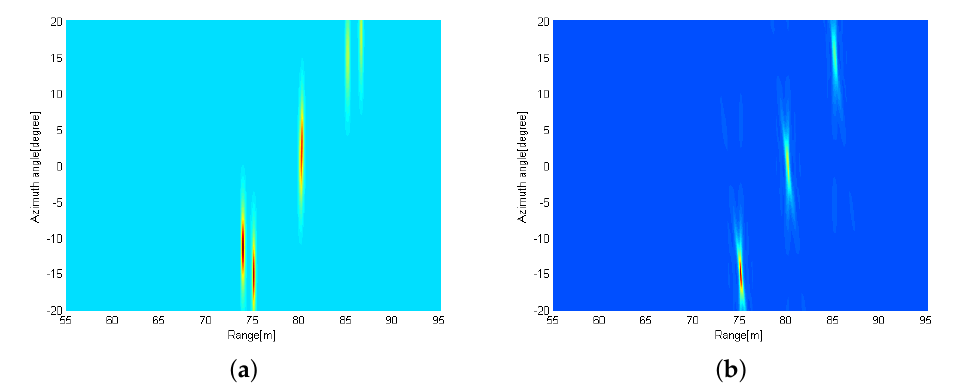
Figure 4. Radar images obtained by using ( a ) the conventional 2D MUSIC with SNR = 10 dB and ( b ) the proposed distributed 2D MUSIC with D = 5 m and SNR = 10 dB.